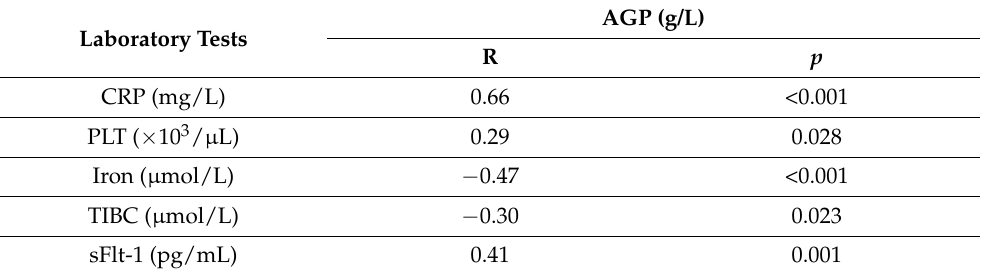
Table 4. Significant correlations between serum concentration of AGP and the results of laboratory tests.